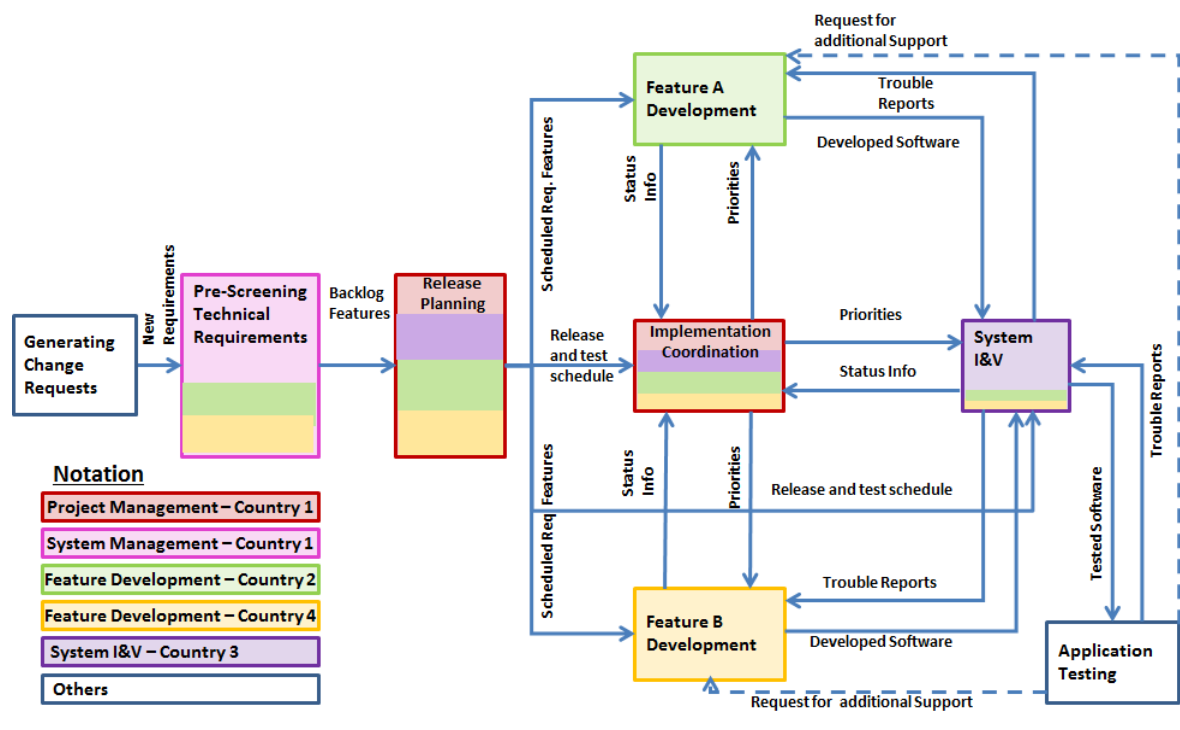
Figure 7. Teams' composition and